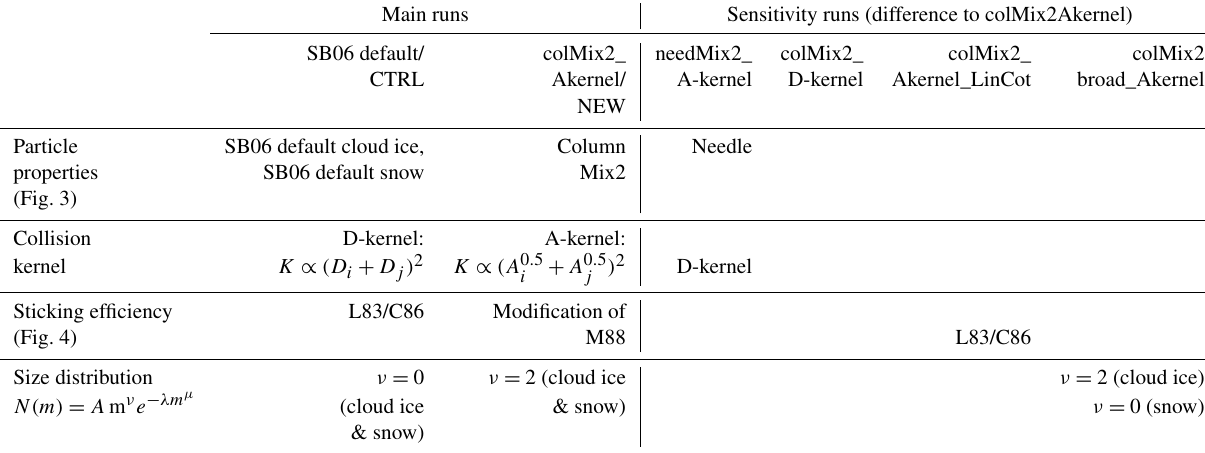
Table 3. Overview of parameters and settings varied in the microphysical sensitivity experiments. The sensitivity runs have the same settings as colMix2_Akernel unless otherwise noted. K is the collision kernel, D the maximum dimension, and A the particle’s projected area; µ and ν are parameters in the generalized gamma function describing the mass distribution in the microphysics scheme (Eq.